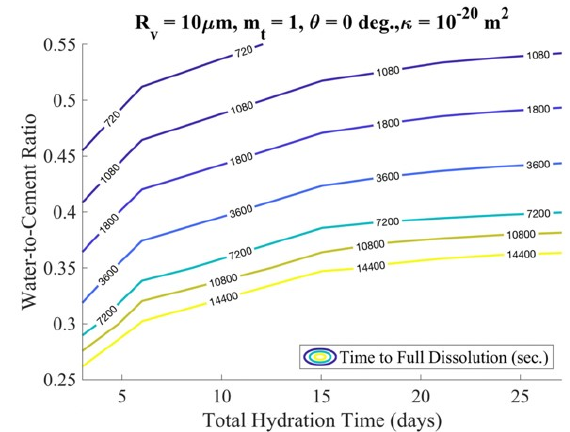
Figure 7. The influence of processing parameters on time to full dissolution using the SVDK model which shows that for hydration times above 15 days, the time to saturation doubles for every 0.05 decrease in the w/c ratio. The processing parameters used to describe the time to full dissolution are w/c ratio and total hydration time at a fixed radius of air void (R v ) = 10 um, a normalized trapped mass of gas (m t ) = 1, contact angle ( θ ) = 0 deg., and intrinsic permeability of hydrated cement paste ( κ ) = 10 ‐ 20 m 2 [41].